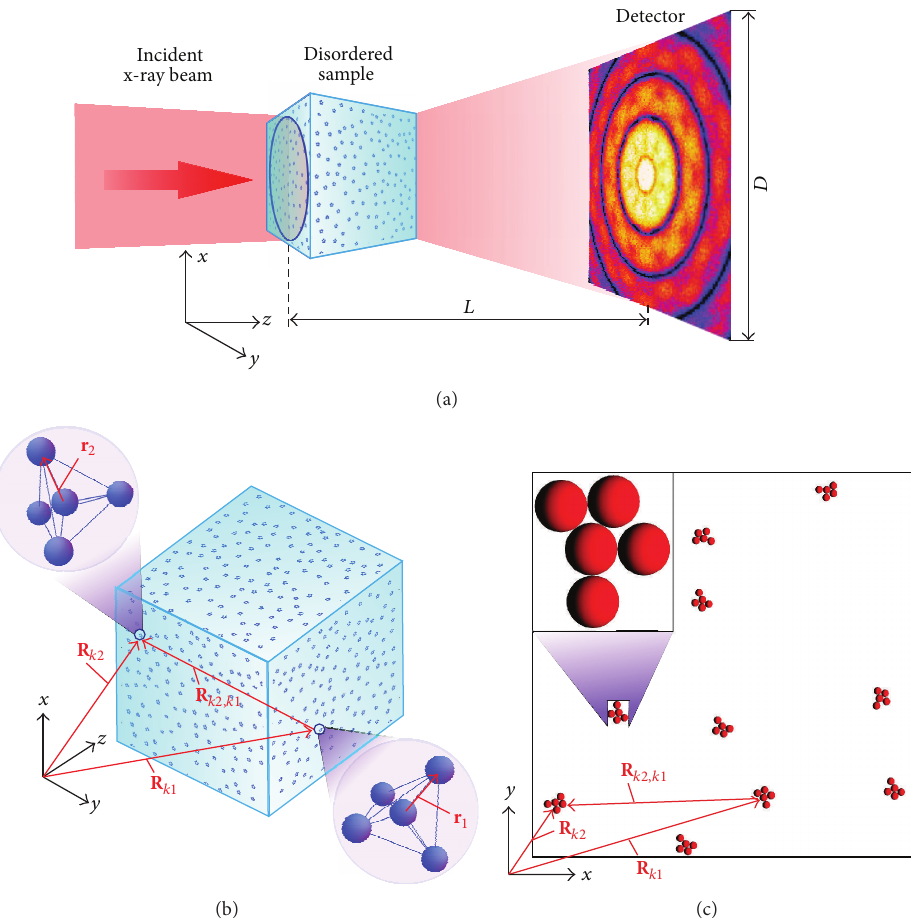
Figure 1: (a) Geometry of the diffraction experiment. A coherent X-ray beam illuminates a disordered sample and produces a diffraction pattern on a detector. The direction of the incident beam is defined along the z -axis of the coordinate system. (b) A disordered 3D sample composed of tetrahedral pentamers. All clusters have random position and orientation in the 3D space. (c) A disordered 2D sample composed of asymmetric clusters. All clusters have random position and orientation in the 2D